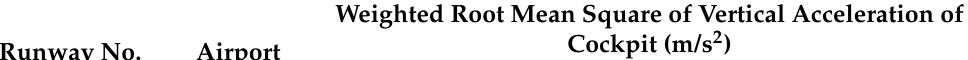
Table 3. Comparison of results for three simulation methods